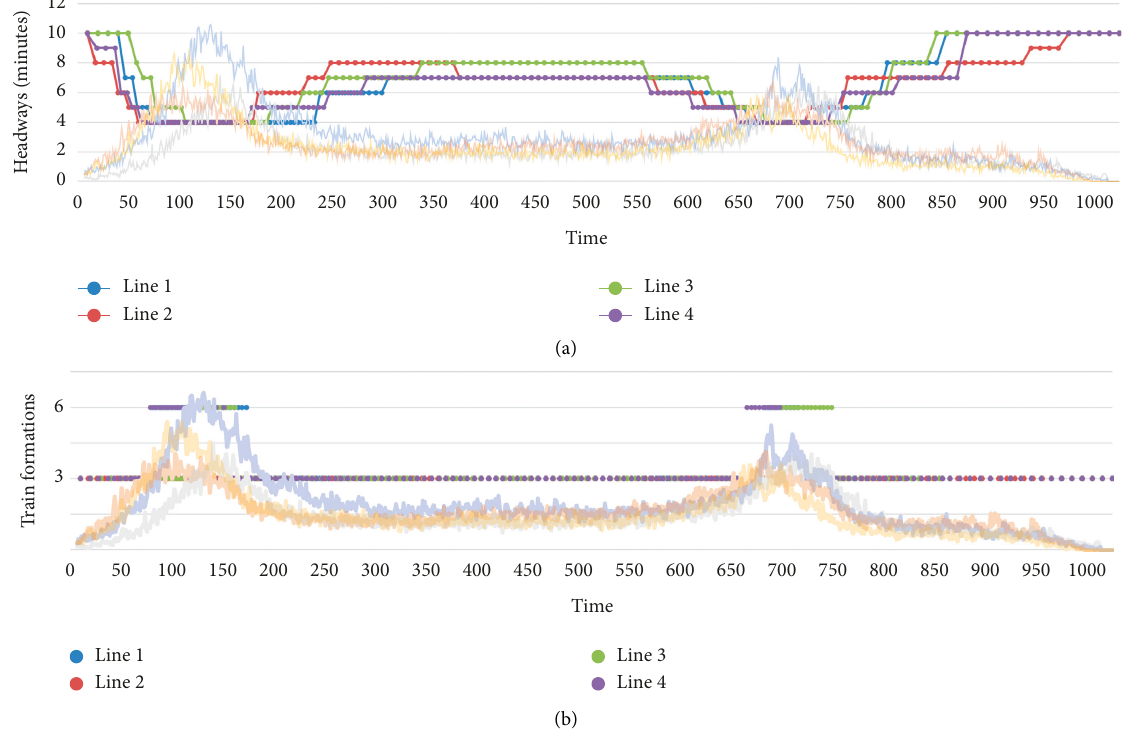
Figure 12: Train operation plan and passenger distribution of 4 lines. (a) Headway of trains at origin stations on each line and (b) the formation of trains on each